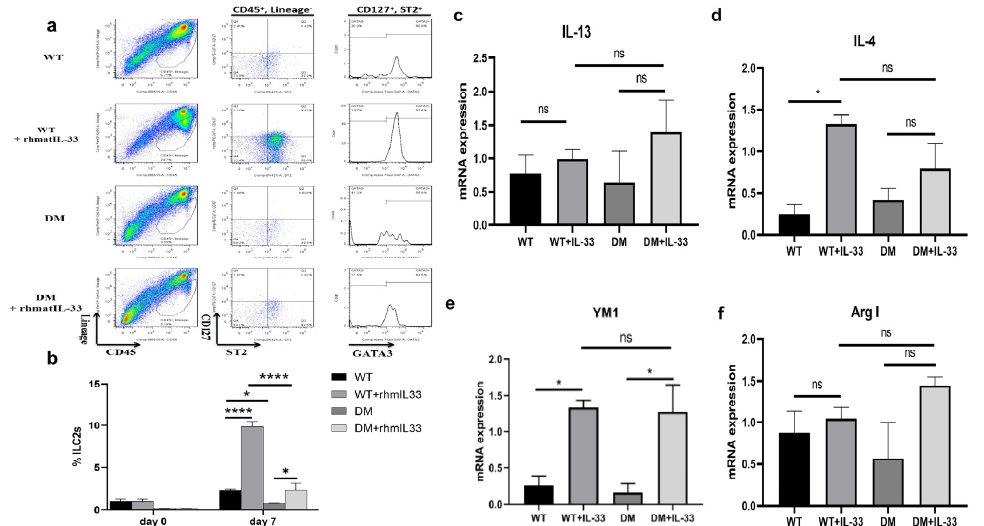
Figure 5. Effects of rhmatIL-33 administration on ILC2 cells in wound tissue. ( a ) Flow cytometric gating strategies for isolation and sorting of ILC2s. ( b ) Bar graphs showing the percentage of ILC2s in the mouse skin at different time points. ( c – f ) Gene expressions of repair-related cytokines in mouse wound skin tissue treated with rhmatIL-33 or PBS by real-time RT-PCR analyses. * p , 0.5; **** p , 0.0001 and ns, not